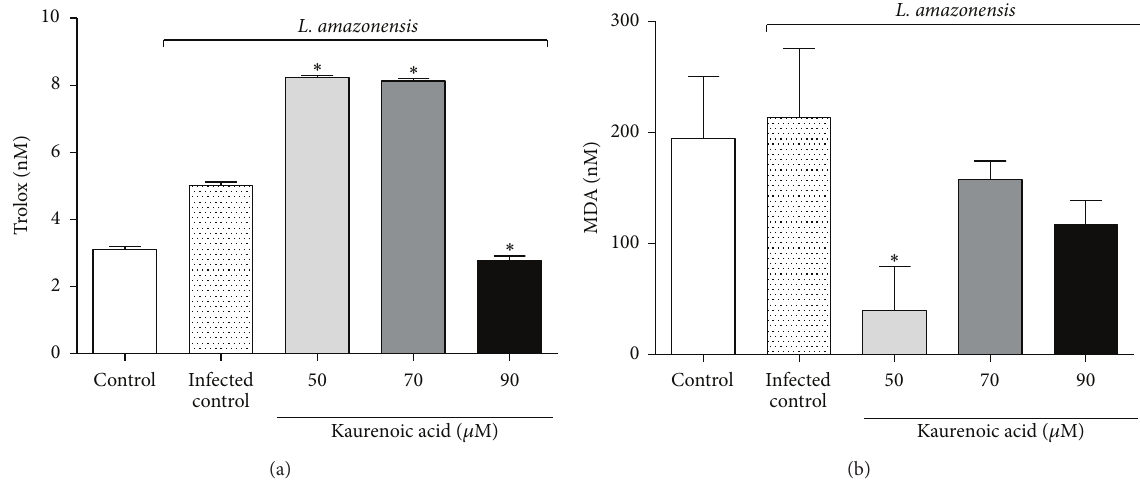
Figure 2: The effect of kaurenoic acid on macrophages is not associated with oxidative stress generation. Total antioxidant capacity (TRAP) (Panel (a)) and MDA levels (Panel (b)) were evaluated as markers of the oxidative status in supernatant or macrophages infected with L. amazonensis and treated with kaurenoic acid (50, 70, and 90 𝜇 M) for 24 h. Data represent the mean ± SEM of three independent experiments. ( ∗ Significantly different from infected cells ( 𝑃 < 0.05 )) (one-way ANOVA followed by Tukey’s test).